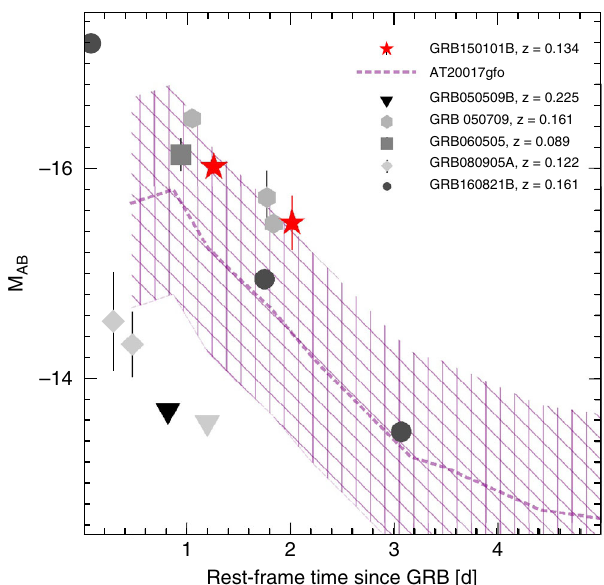
Fig. 6 Early optical emission from short GRBs. Comparison between the kilonova AT2017gfo (dashed line; the hatched area shows the ±1 mag region) and the optical counterparts of nearby short GRBs. Vertical error bars are 1 σ . Downward triangles are 3 σ upper limits. Due to the limited spectral coverage of most events, we did not apply a k-correction and present the absolute magnitudes in the observed r-band fi lter. However, given the low redshift of these events, we expect this correction factor to be <0.5 mag. The data are from refs. 40,66 –